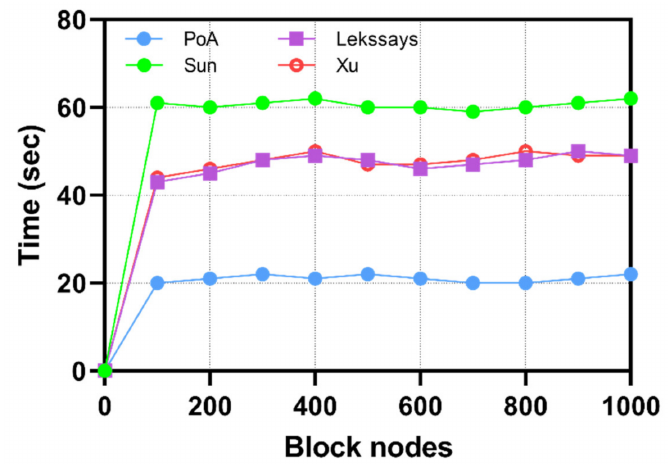
Figure 7. Comparison analysis of consensus algorithms to DDoS